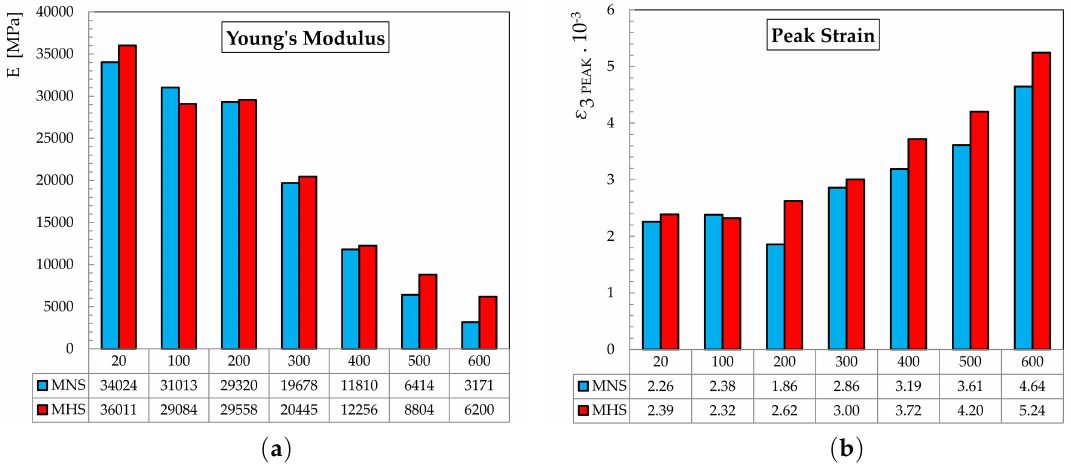
Figure 13. Uniaxial Compression: Evolution with temperature of ( a ) Young’s Modulus and ( b ) Peak